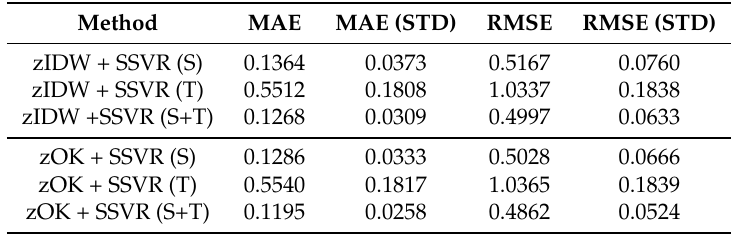
Table 5. Results with synthetic